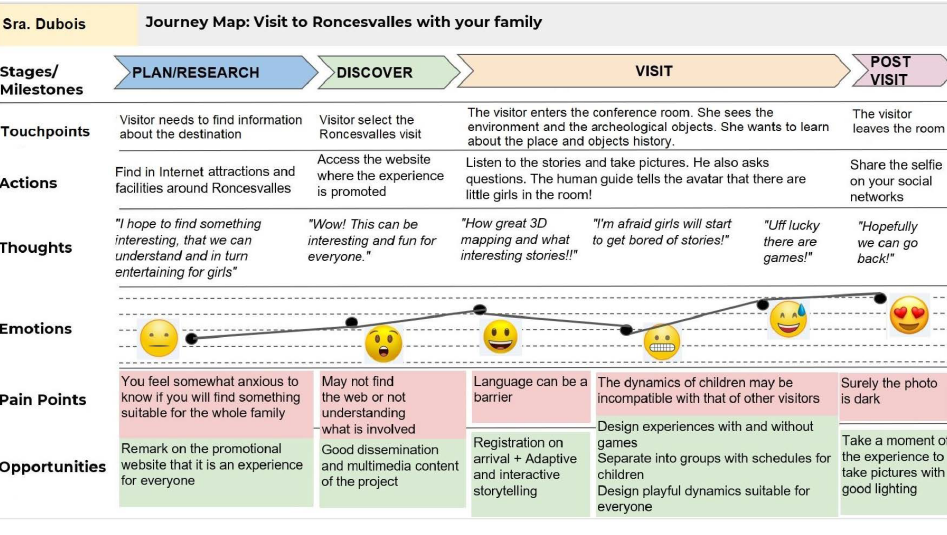
Figure 2. High level Mrs. Dubois’s Journey